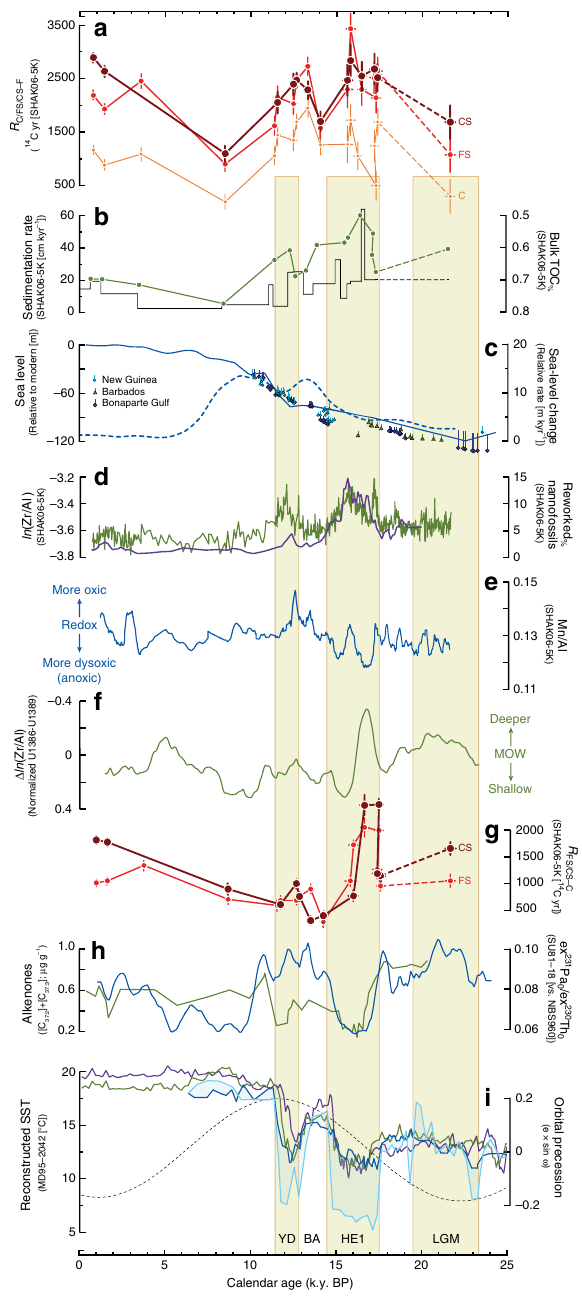
Fig. 3 Deglacial trends in down-core records at SHAK06-5K and vicinal Iberian Margin ocean cores. Comparison of down-core sedimentary proxies at Iberian margin sites during glacial termination and Holocene.